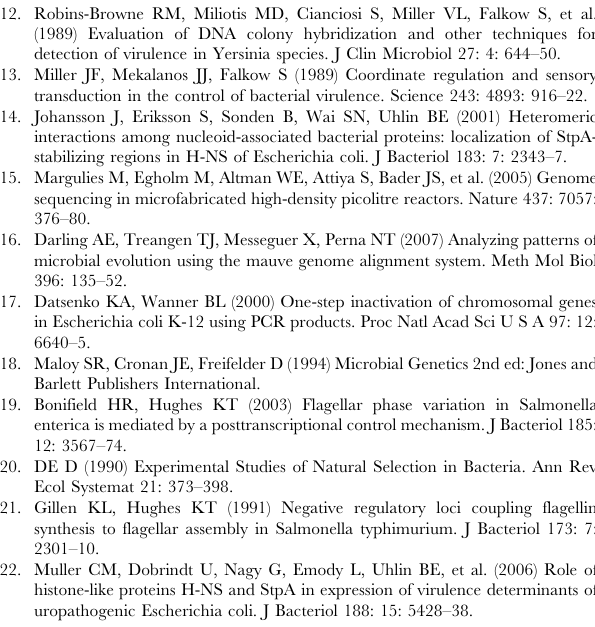
Table S1 Genome Sequencing Statistics by Strain. Table S2 Sequence differences between strain JB124